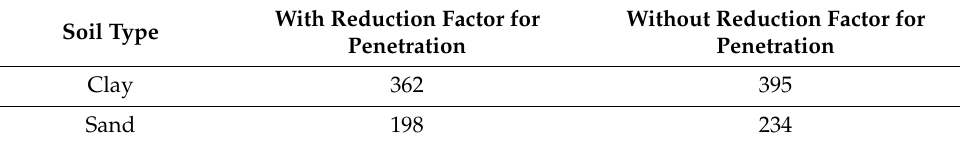
Figure 6. The mean displacement plus one standard deviation for the cases with / without reduction factor. Table 9. The required submerged weight (KN / m) for the cases with / without reduction factor. With Reduction Factor Soil Type